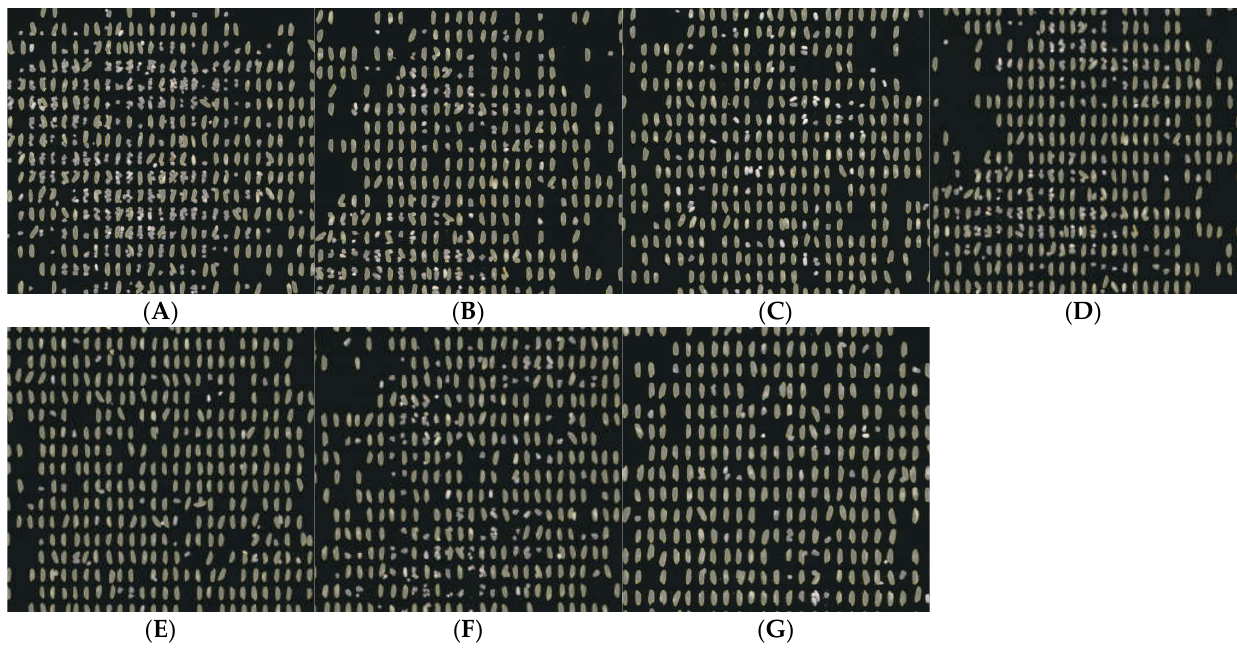
Figure 5. Rates of head rice rate for paddy with different drying methods: ( A ) 32.6% sun drying, ( B ) 32.6% mechanical drying, ( C ) 32.6% late harvest, ( D ) 24.4% sun drying, ( E ) 24.4% mechanical drying, ( F ) 18.7% sun drying, ( G ) 18.7% mechanical